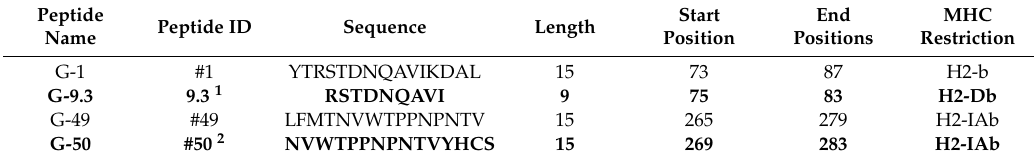
Table 2. Information on 8–11mer peptides used for H2-b-restricted epitope